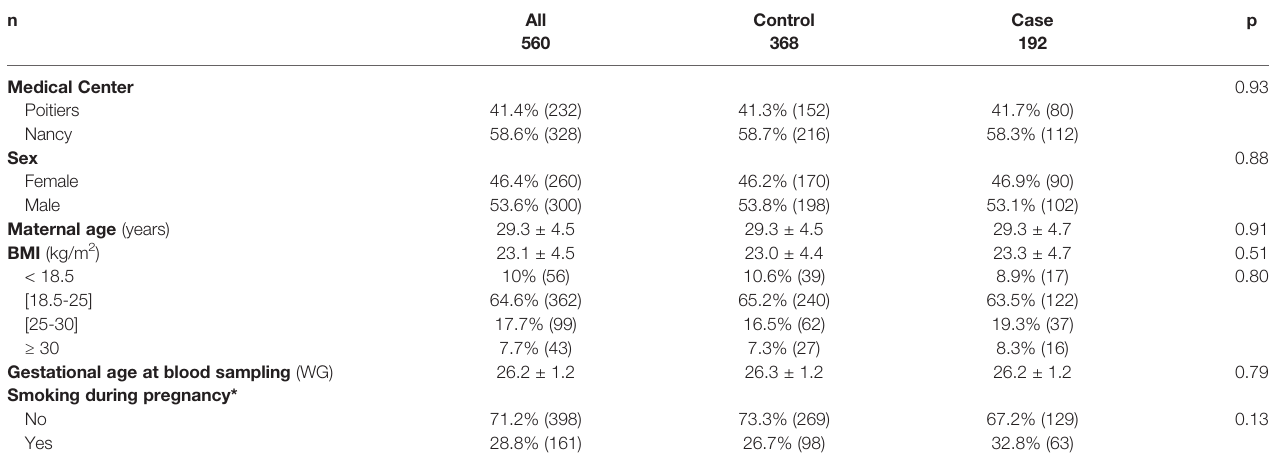
TABLE 1 | Characteristics of the matched case and control pregnancies from the EDEN mother-child cohort. n All